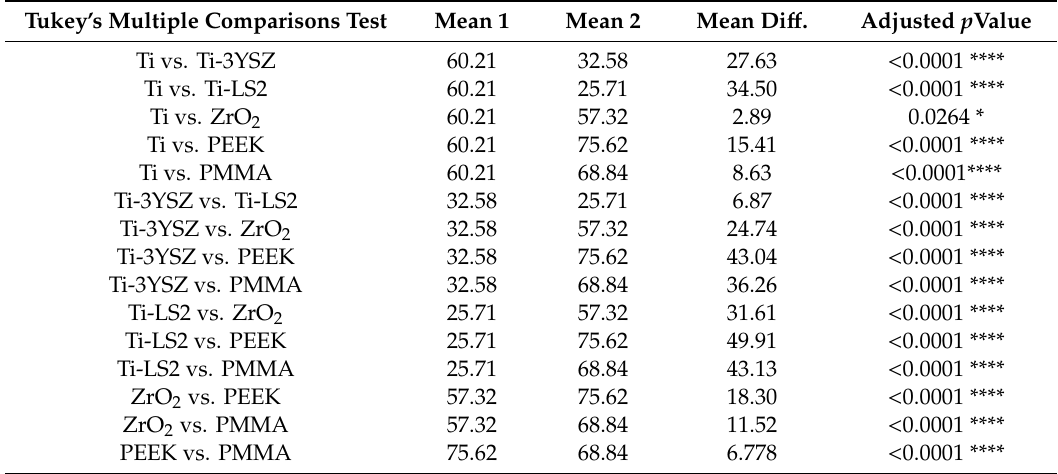
Table 3. Multiple comparisons of surface WCA (deg.) among groups ( n = 10 for each group) by